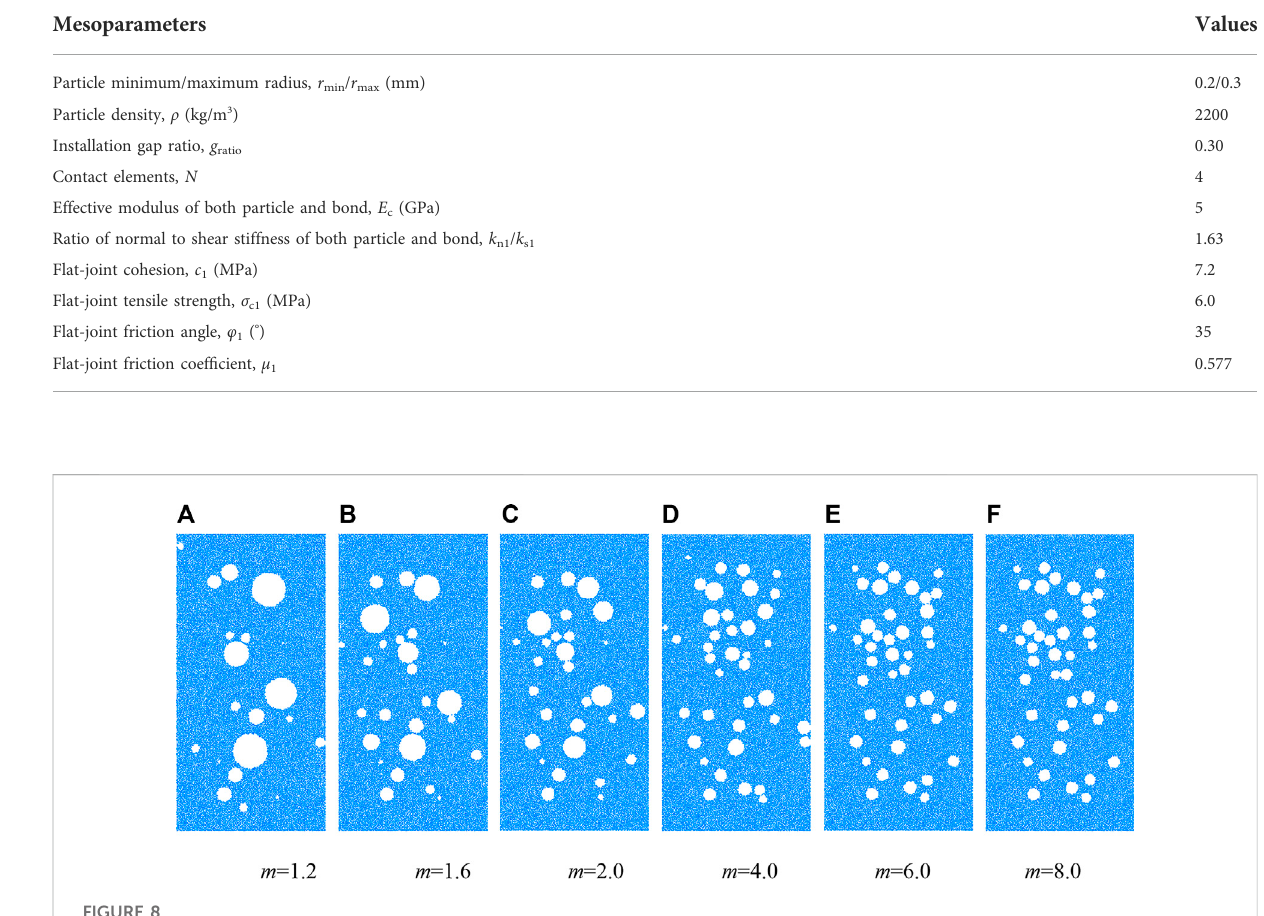
TABLE 1 Summary of the calibrated mesoparameters of the fl at-joint model.